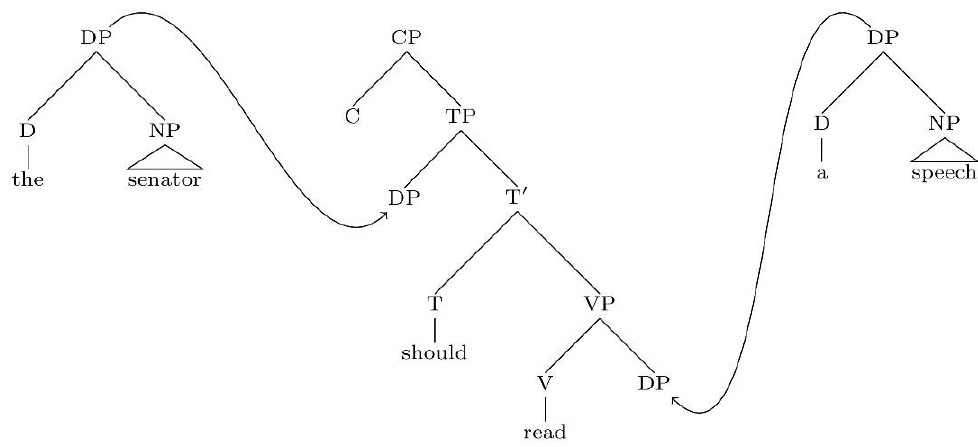
Figure 9. Derivation of ‘the senator should read a speech’ according to